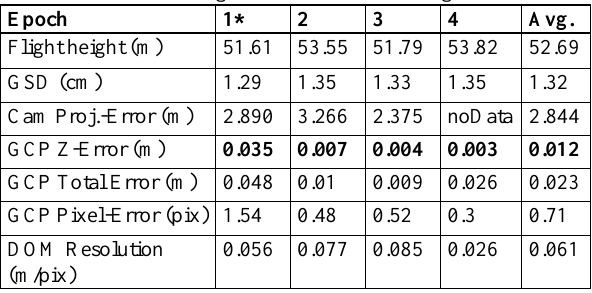
Table 1. Georeferencing information of UAS-flights